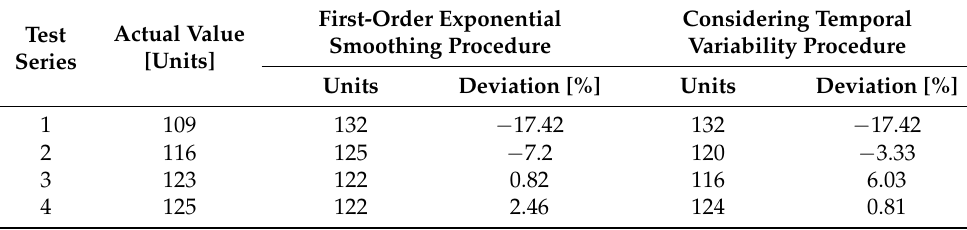
Table 3. Planned and actual values of the test series with percentage